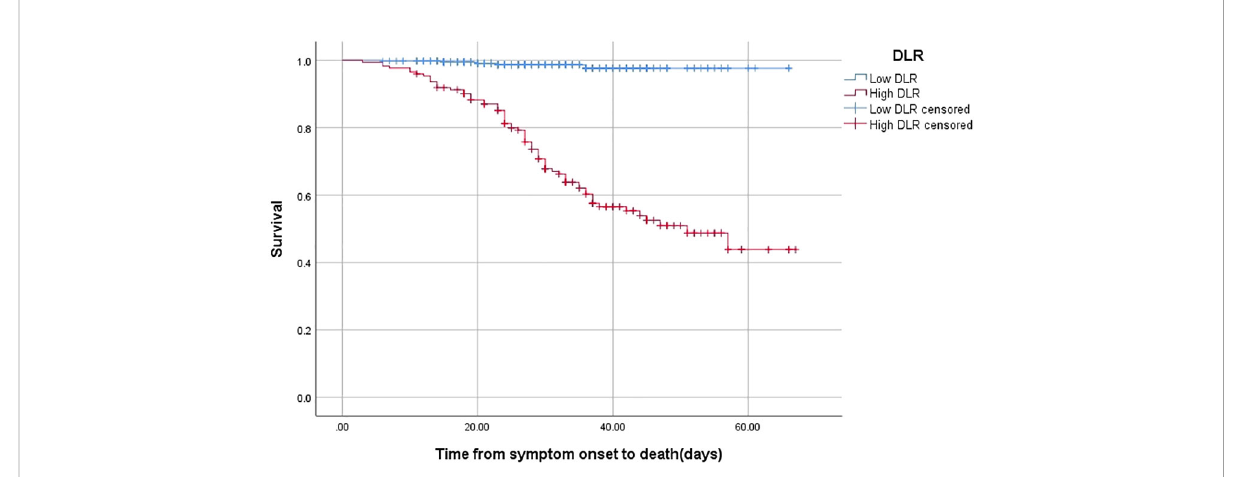
FIGURE 2 The time-dependent risk of death in COVID-19 patients with low and high DLR using Kaplan-Meier curve. Patients with high DLR showed a worse survival compared with those with low DLR (Log Rank P <